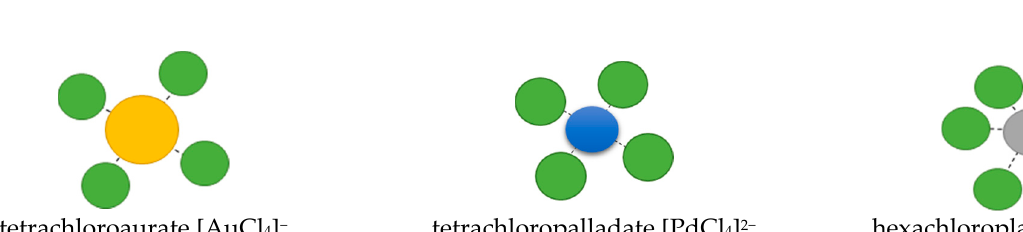
chloride for (cid:4) —0.1; • —0.5; (cid:78) —1; (cid:72) —2; (cid:7) —3; and - 5 M HCl concentration. The initial concentration of each metal ion is EDAB ‐ acac in methylene chloride for ■—0.1 ; ●—0.5 ; ▲—1 ; ▼ —2;  —3; and  ‐ 5 M HCl concen ‐ (cid:16) 1 mM. tration. The initial concentration of each metal ion is 1 mM.